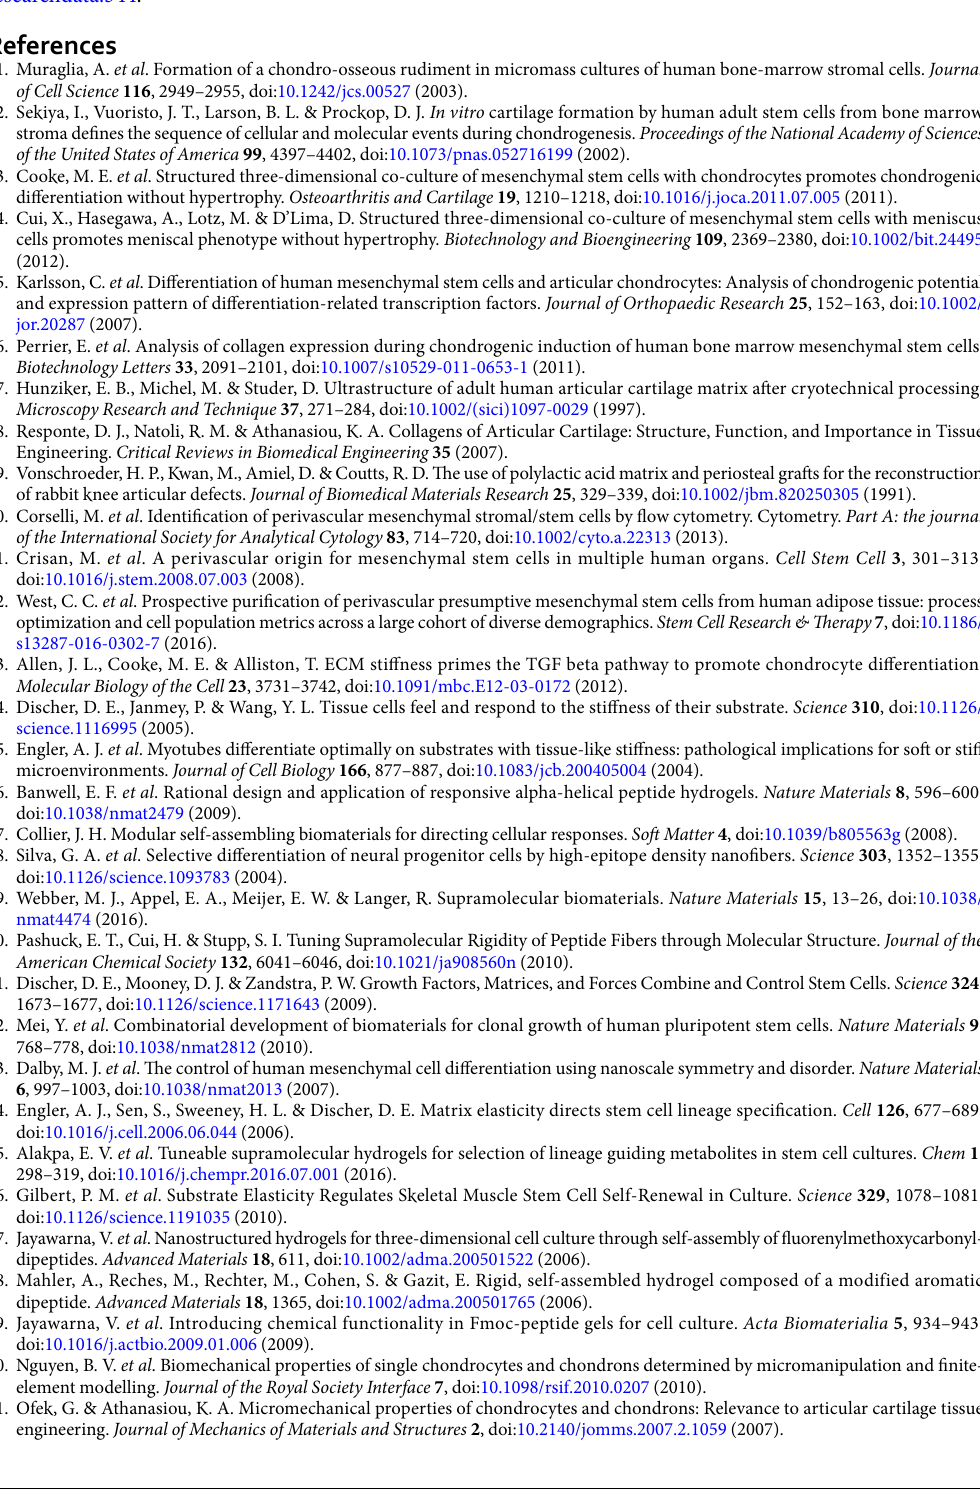
Analysis of variance (ANOVA) and Bonferroni post hoc tests were performed using GraphPad prism software to compare more than two study groups. Statistical significance is noted where the calculated p value is less than 0.05 using four biological replicates unless otherwise stated. Multivariate analysis of the LC-MS data and metabolite pathway mapping were done using